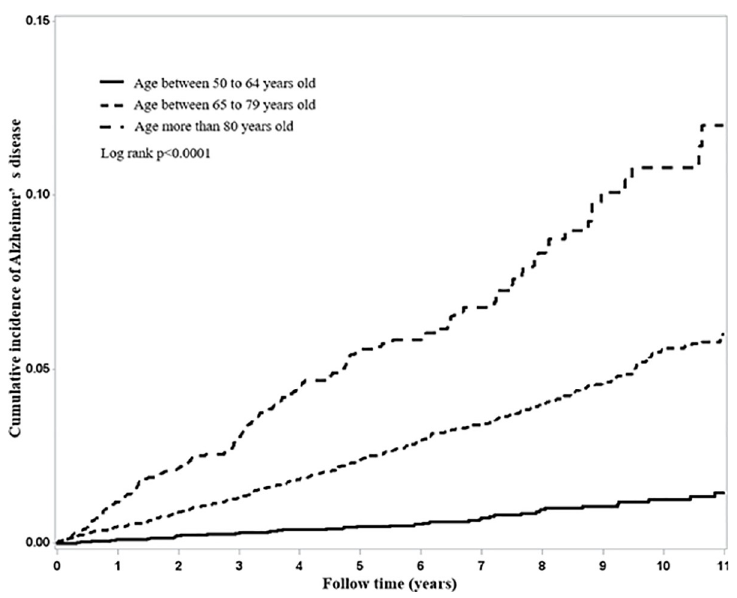
Fig 2. Kaplan-Meier plot of the cumulative incidence of Alzheimer’s disease in each age